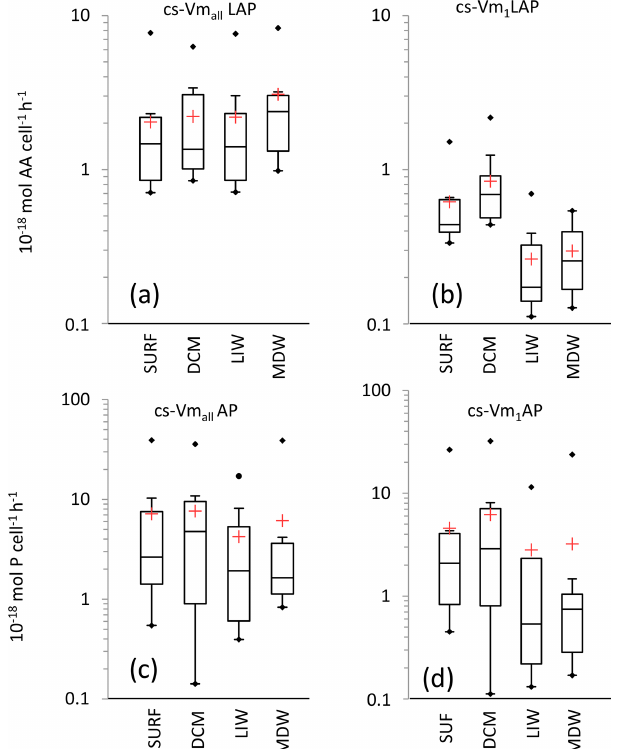
Figure 8. Box plot distributions of cell-specific (cs) Vm 1 and Vm all for leucine aminopeptidase (a, b) and alkaline phosphatase (c, d) . Box limits are the 25% and 75% percentiles; the horizontal bar is the median; the red cross is the mean; black dots are outliers.